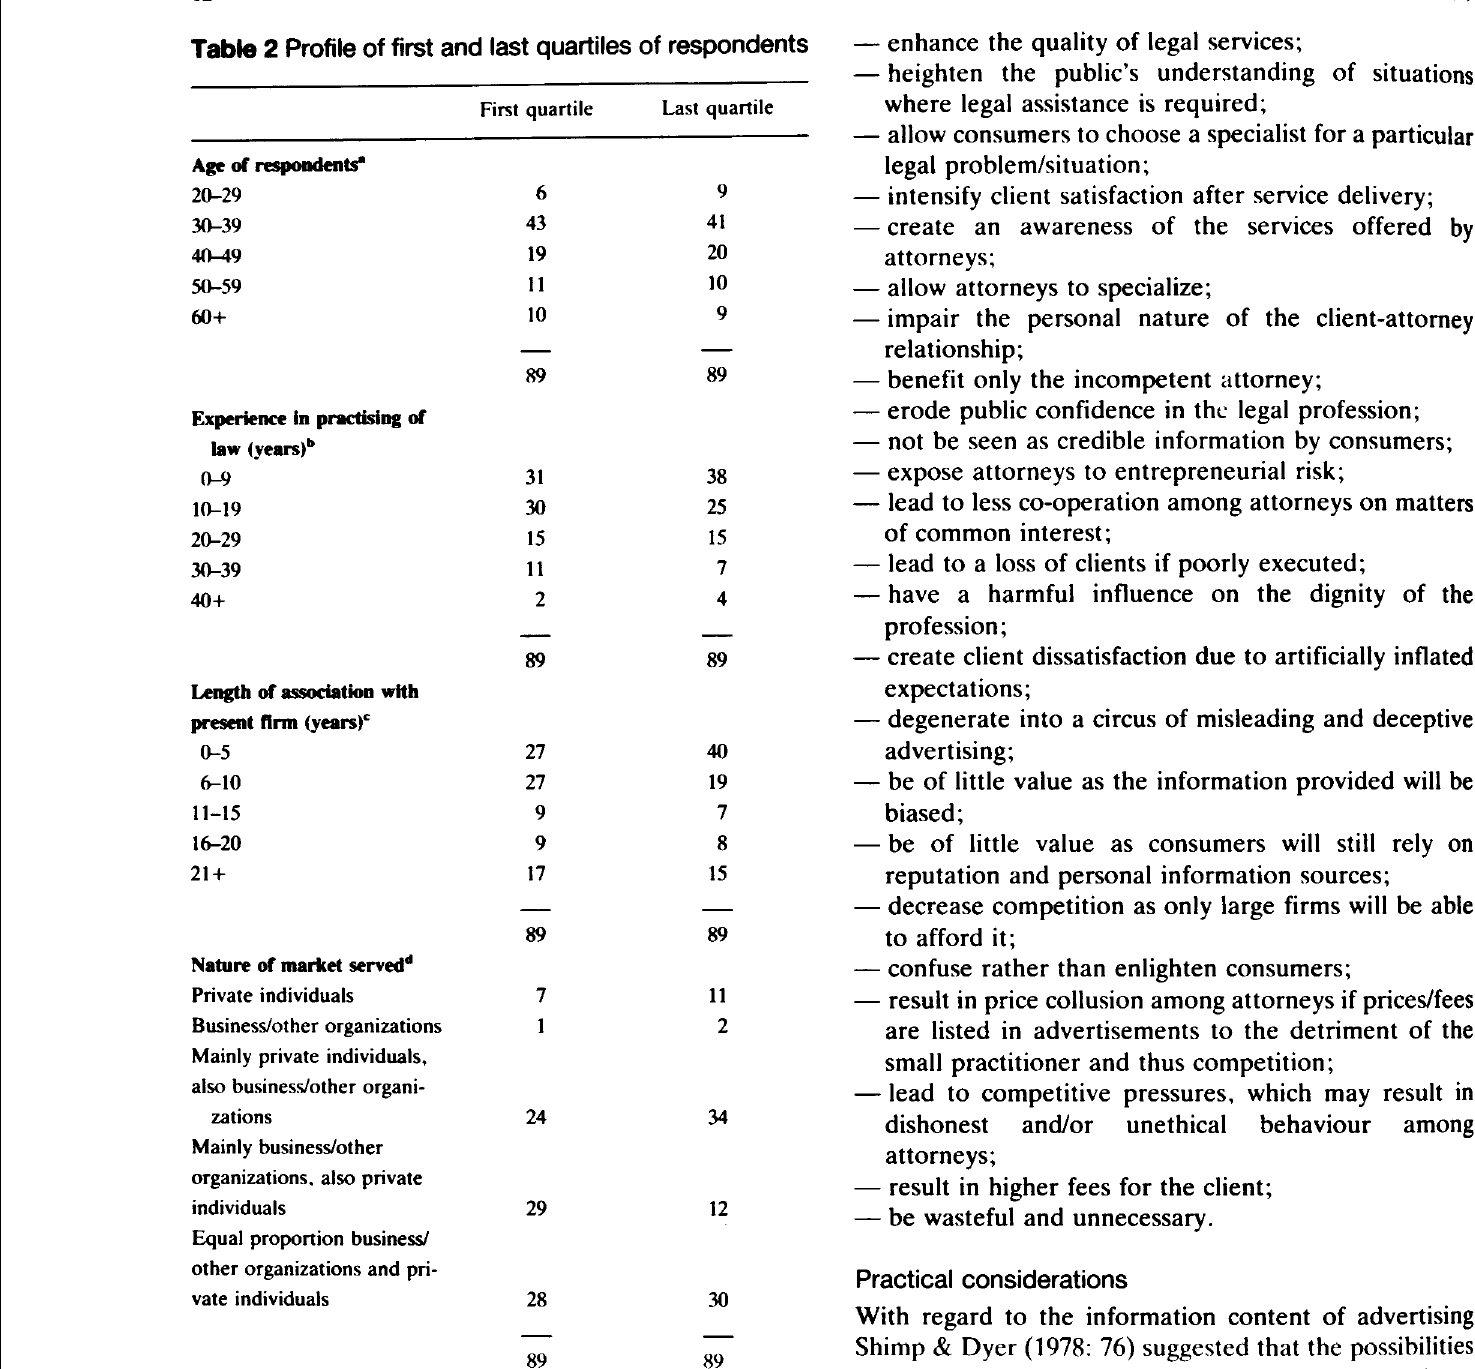
Table 2 Profile of first and last quartiles of